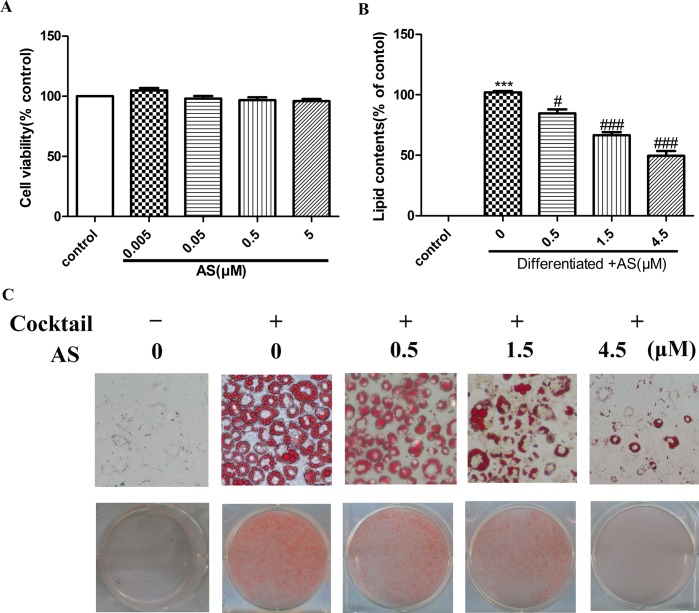
AS inhibits 3T3-L1 preadipocyte differentiation and fat accumulation.(A) Cell viability was assessed with the MTT assay24 h after AS treatment. (B) Relative lipid content. (C) Inhibition of fat droplet formation by AS. 3T3-L1 cells were seeded and induced to differentiate for 8 days with or without AS in 6-well plates, then stained with Oil Red O and imaged by light microscopy (200×). Values are expressed as mean ± SEM. Significant differences were observed between the untreated and differentiated control cells. *P < 0.05, **P < 0.01, **P < 0.001 vs. AS-treated cells; #P < 0.05, ##P < 0.01, ###P < 0.001 vs. differentiated control cells.